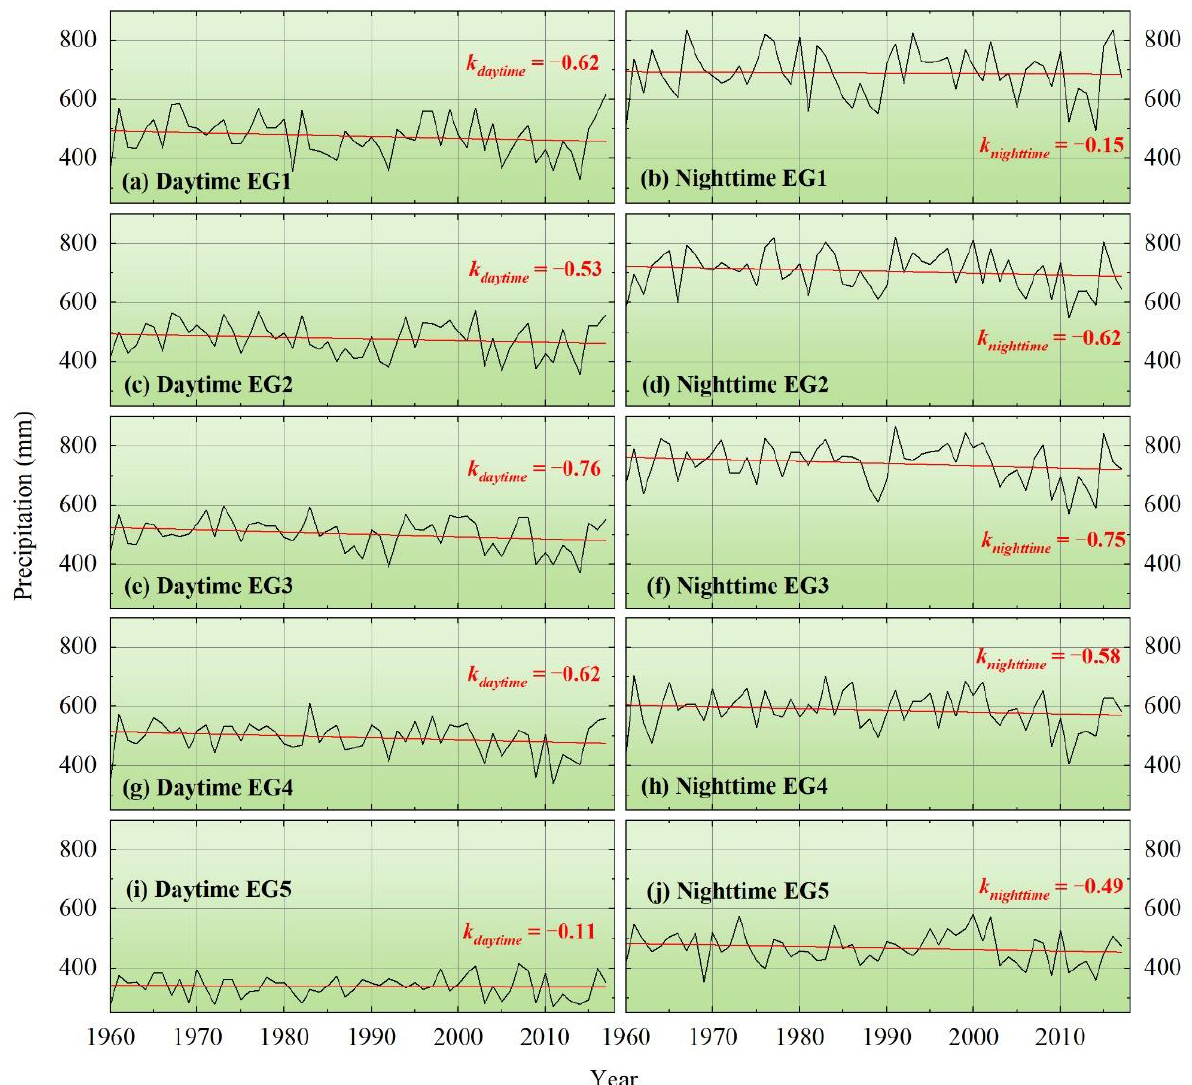
Figure 7. Variation in annual average precipitation in different altitude gradients.